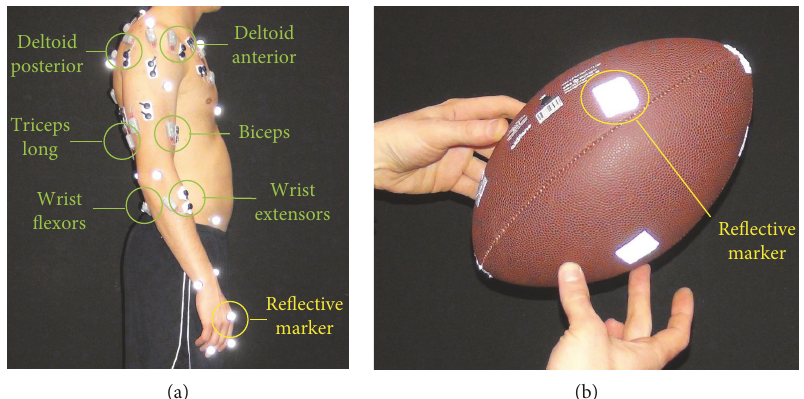
Figure 3: Marker and EMG placement [33, 34]. Recommendations were followed for the EMG placement, whereas re fl ective markers were placed following the ISB recommendations with small adjustments [38 – 41].